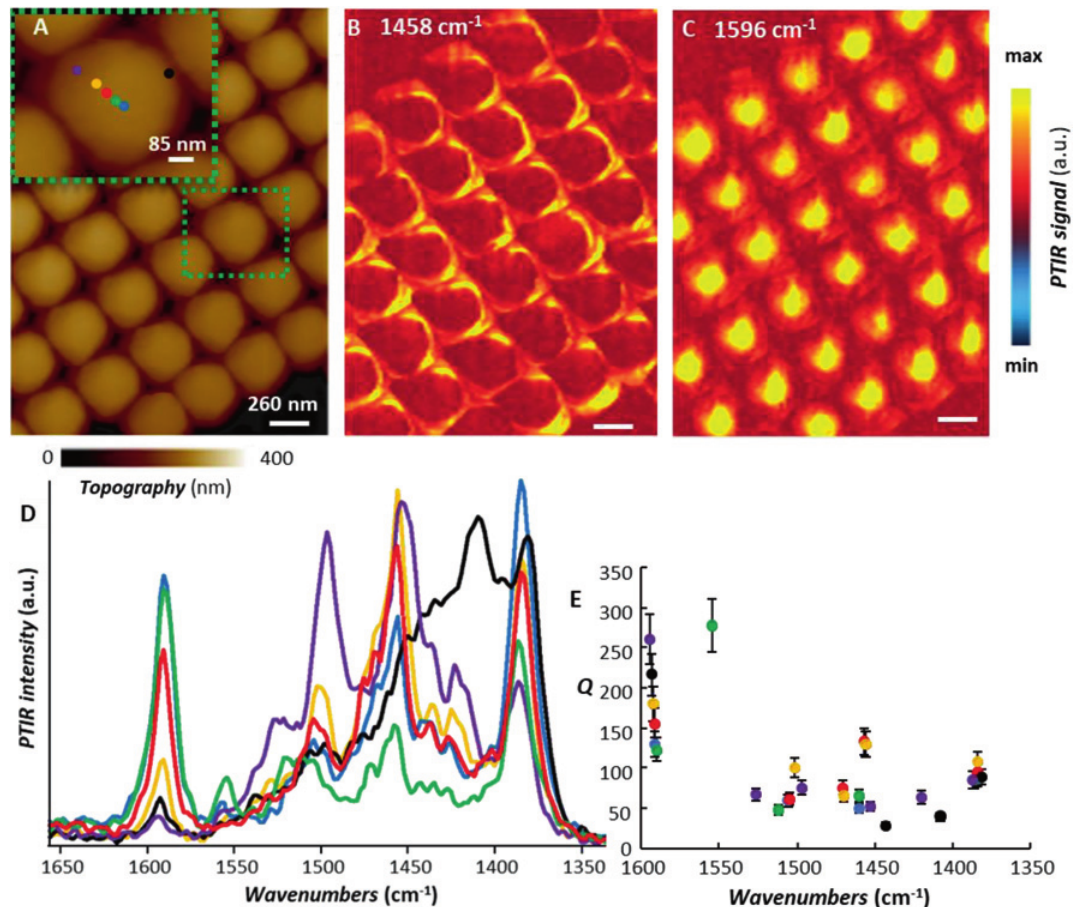
Figure 5: (A) sample-3 ( Ar ≈ 1.16) AFM topography; the inset highlights the area from where the color coded PTIR spectra were obtained. (B) tapping-modePTIRabsorptionmapat1458cm − 1 (C)tapping-modePTIRabsorptionmapat1596cm − 1 Allimages(4.7and20nmpixelresolution in the vertical and horizontal directions respectively) were obtained with a scan rate of 0.2 Hz using probe-B. Scale bars are 260 nm for the images and 85 nm for the inset. (D) tapping mode PTIR spectra obtained at the color-coded position marked in the inset. The spectra are displayed in common scale. (E) Q -factors of the polariton resonances obtained from the color-coded spectra in panel-d. The error bars represent a single standarddeviation in the determination of Q and mainly determinedby the uncertainty of determining the peaks FWHM via the least square fi tting the resonances with Lorentzian peak